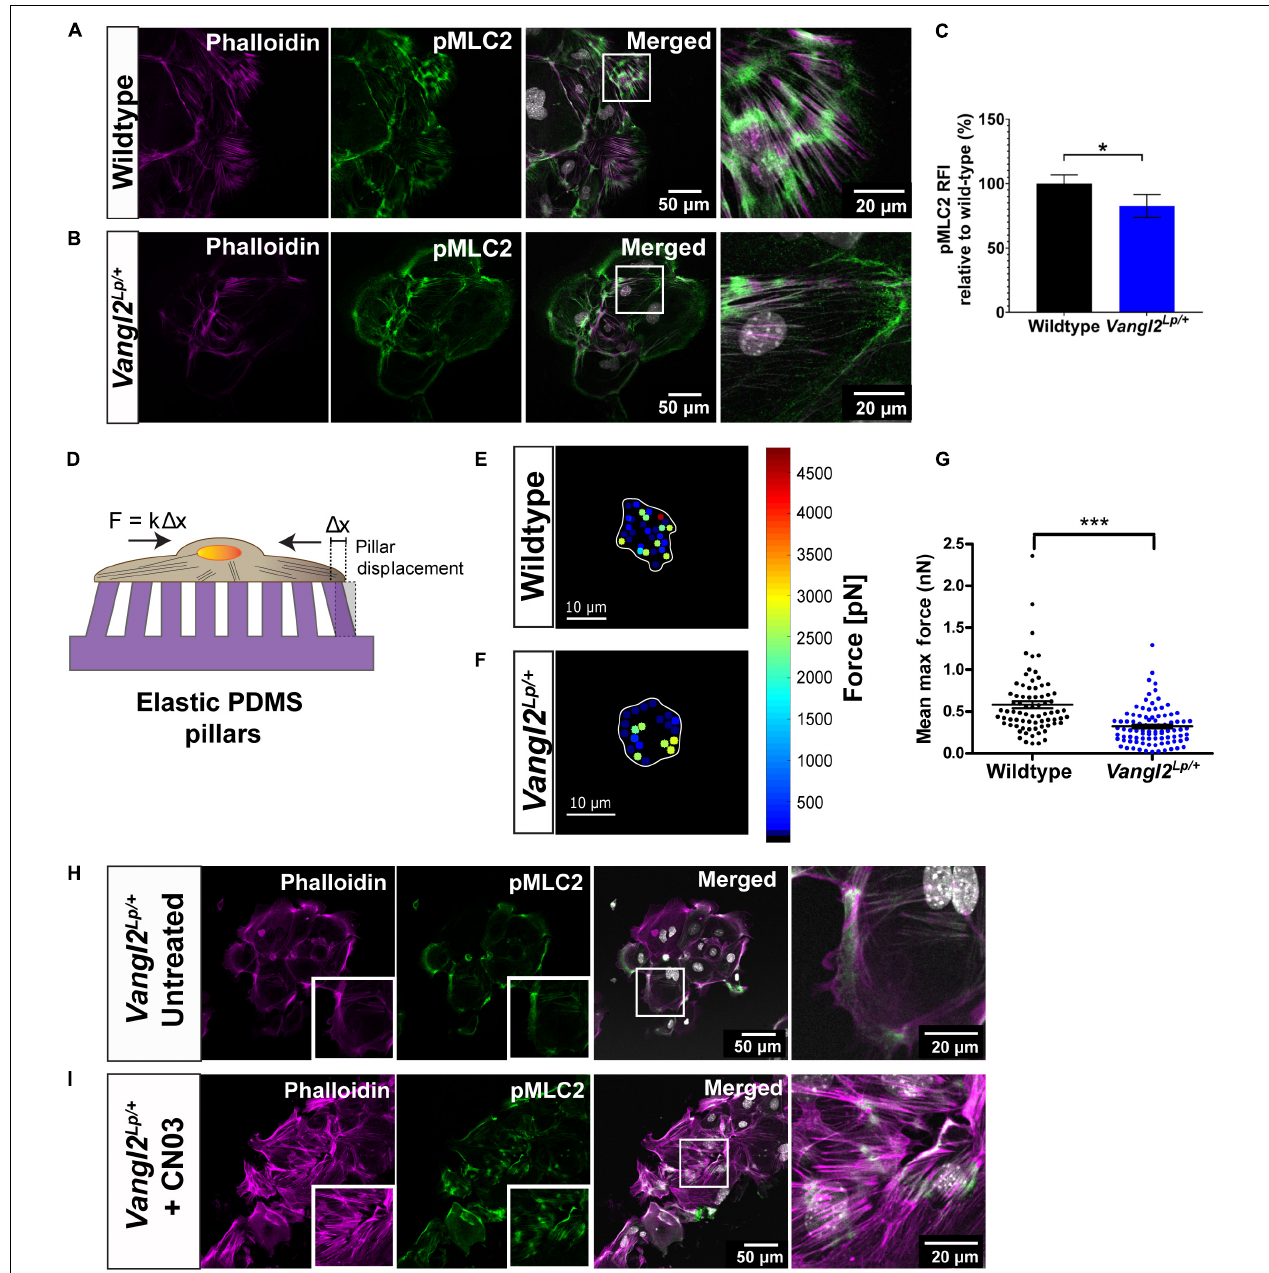
FIGURE 5 | VANGL2 regulates MLC2 activation and force generation via RhoA signaling. Representative images showing wildtype (A) and Vangl2 Lp / + (B) TECs stained with pMLC2 (green) and phalloidin (magenta). Nuclei are shown in gray (DAPI). (C) Quantification of pMLC2 relative fluorescence intensity (RFI) in Vangl2 Lp / + relative to wildtype (presented as mean ± SEM). n = 3 independent experiments; TECs from three mice were pooled for each group per experiment; two technical replicates for each group per experiment; at least three fields were taken per technical replicate. Mann–Whitney U -test, * p < 0.05. (D) Schematic representation of the elastic micropillars used to measure cellular traction forces. Cells were seeded on a rat-tail collagen I coated array of micropillars and incubated at 37 ◦ C with 5% CO 2 for 24 h. Individual pillar deflection from its original position in the array ( (cid:49) x) is tracked via time-lapse microscopy and converted to traction force based on the pillar spring constant ( k = 1.36 nN/ µ m). Heat maps of the traction forces distribution in a representative wildtype (E) and Vangl2 Lp / + (F) TEC. Cell boundary is outlined in white. (G) Quantification of the mean maximum traction forces exerted by wildtype ( n = 75 cells) and Vangl2 Lp / + TECs ( n = 92 cells) on the micropillars (presented as mean ± SEM). n = 2 independent experiments; in each experiment, tracheas from three separate mice were pooled for each group; two technical replicates for each group per experiment; each dot represents mean maximum traction force per cell. Two-tailed unpaired Student’s t -test, *** p < 0.001. Representative images showing Vangl2 Lp / + TECs without treatment (H) and Vangl2 Lp / + TECs treated with Rho activator, CN03 (I) . TECs were stained with pMLC2 (green) and phalloidin (magenta). Nuclei were stained with DAPI (gray). n = 3 independent experiments; TECs from three mice were pooled for each group per experiment; two technical replicates for each group per experiment.